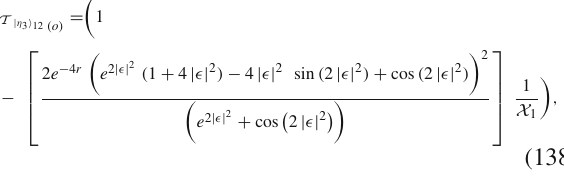
(d) The D T is plotted as a function of coherent pa- | η 3 (cid:2) 12 ( e ) rameter for fixed values of squeezing parameters. Here, with D T (c) The is plotted as a function of squeezing pa- the increasing values of coherent parameter the nonclassical | η 3 (cid:2) 12 ( e ) rameter for fixed values of coherent parameters. Here, with character of the | η 3 (cid:2) states decreases to an extent where we (cid:3) 1. increase in the strength of squeezing the D T may regard D T increases. | η 3 (cid:2) 12 ( e ) | η 3 (cid:2) 12 ( e ) Fig. 16 a isthearrayplot and b – d aretherespectivelythe3-Dand2-D r . Note that | η 3 (cid:3) 12 state is semiclassical state with D T (cid:10) 1 only when | (cid:11) | (cid:14) r , otherwise the states are very quantum with D T ≈ 1 plots for the D T parameter in 3rd quasi-Bell state of TMSEC states, plotted as a function of coherent parameter | (cid:11) | and squeezing parameter